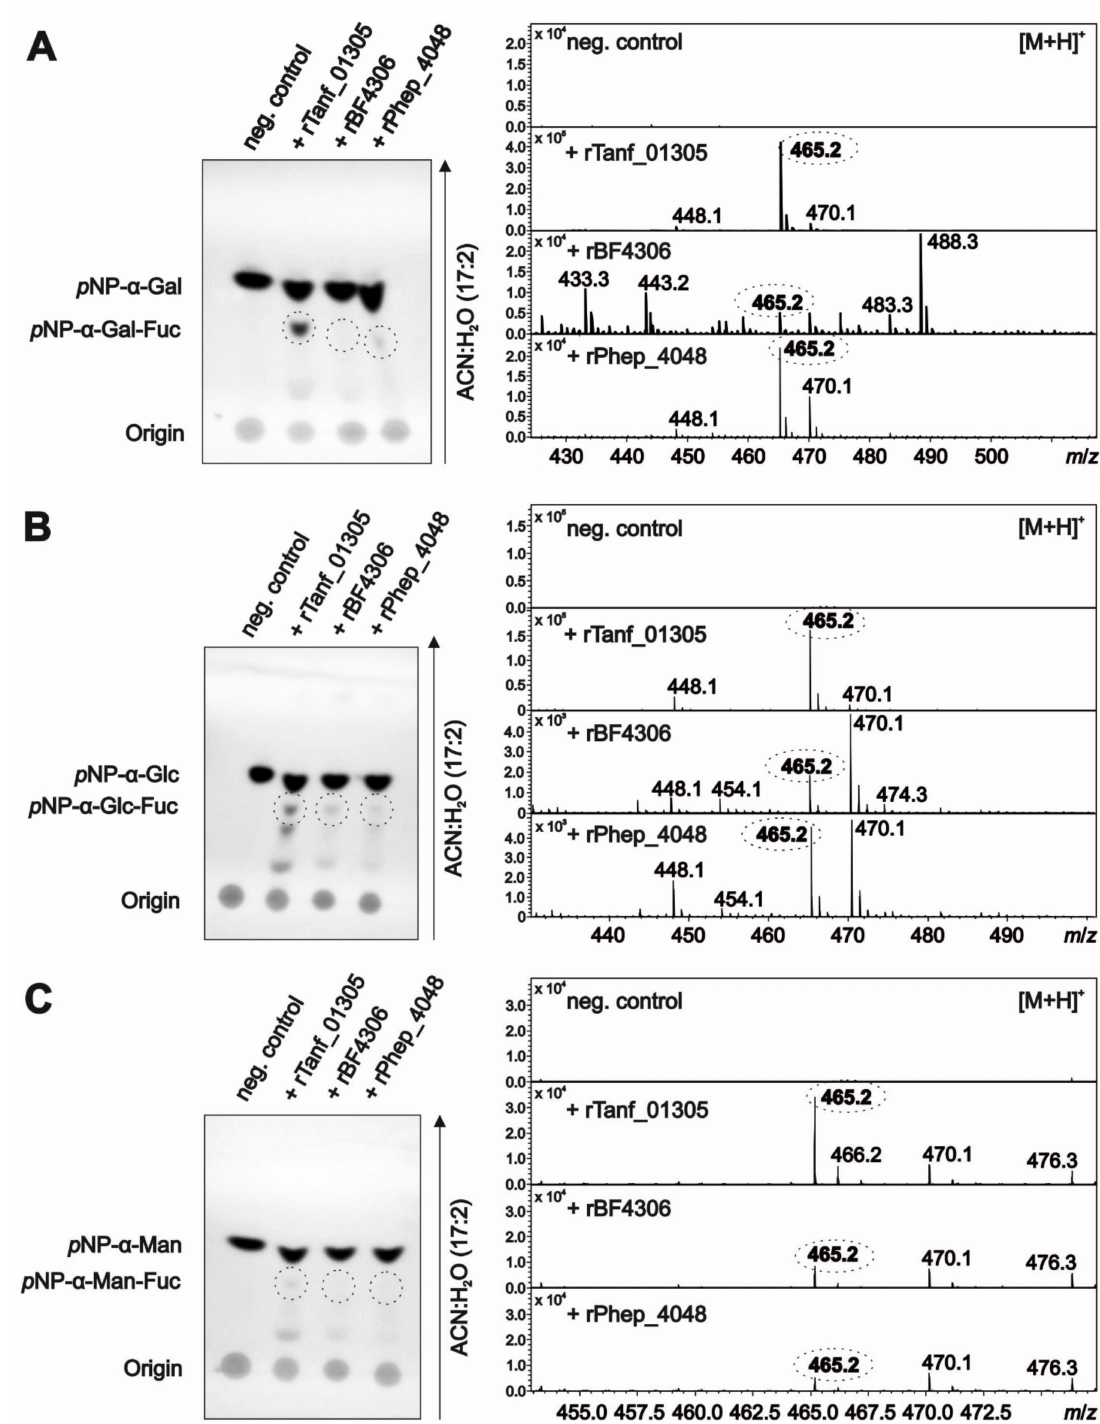
Figure 11. In vitro fucosyltransferase activity assays on p NP- α - L -hexoses. Developed TLC plates in combination with MS analysis show the formation of ( A ) p NP- α - D -Gal-Fuc, ( B ) p NP- α - D -Glc-Fuc, and ( C ) p NP- α - D -Man-Fuc when using recombinant FucTs from T. forsythia (rTanf_01305), B. fragilis (rBF4306), and P. heparinus (rPhep_4048) respectively. To determine the product masses corresponding to the detected spots on TLC plates, the reaction product (marked by a dashed circle) was eluted from the TLC plate and analyzed by ESI-MS. The mass corresponding to a p NP- α - D -Hex-Fuc product (465.2 m / z ) is written in bold in a dashed circle. Peak intensities are given on the y axis. Negative controls were assay mixtures without